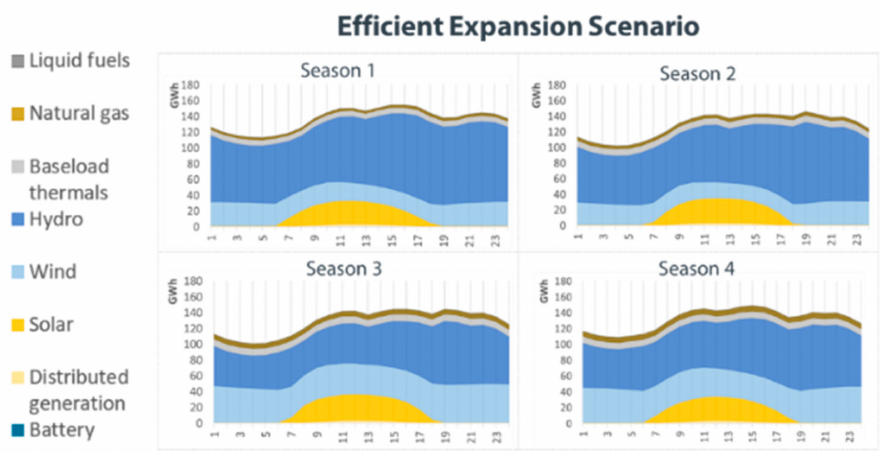
Figure 11. Generation profile per season in the efficient regulation